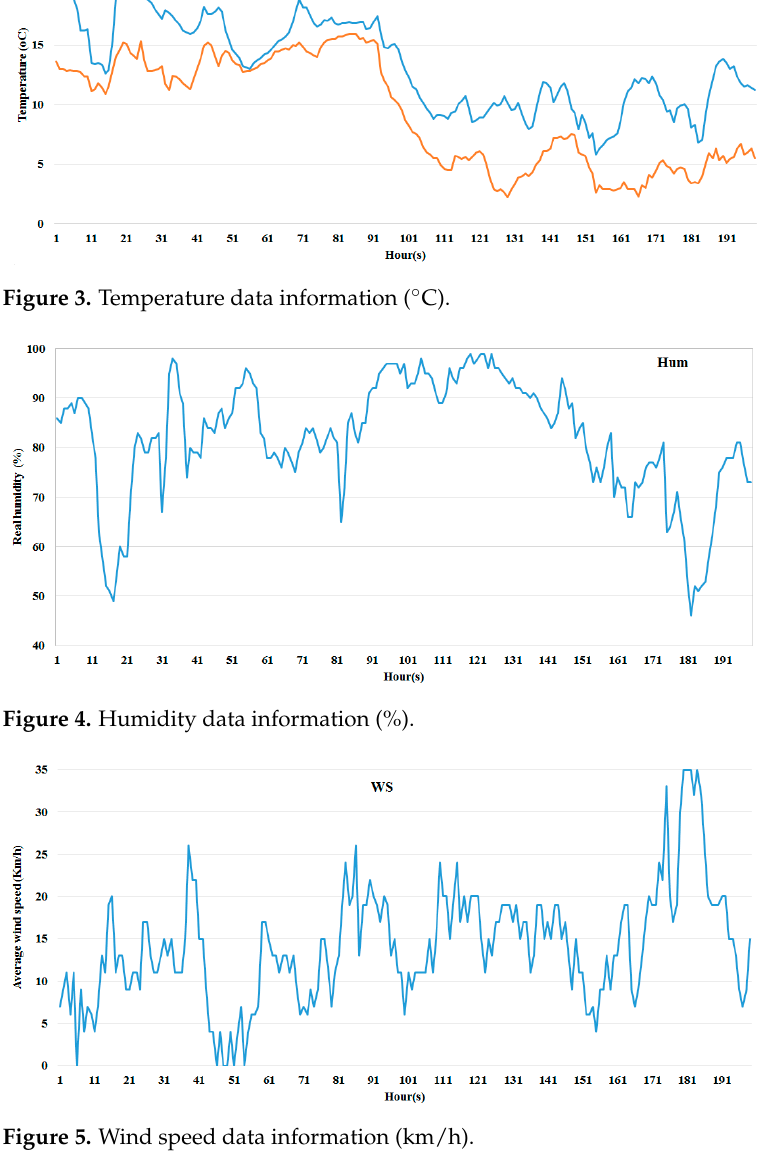
Figure 6. Outside air pressure data information (kPa).